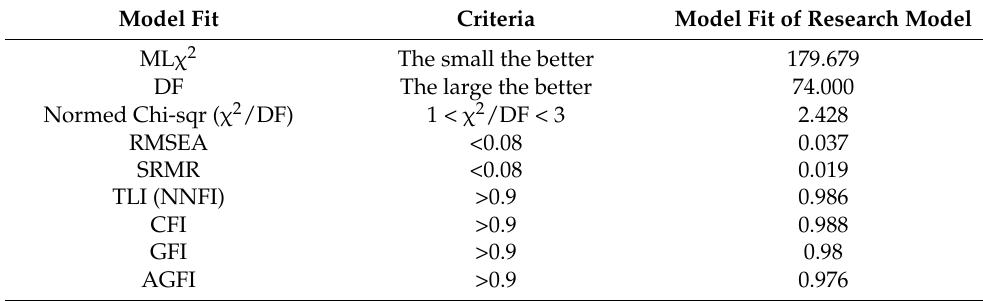
Table 6. Model fit.